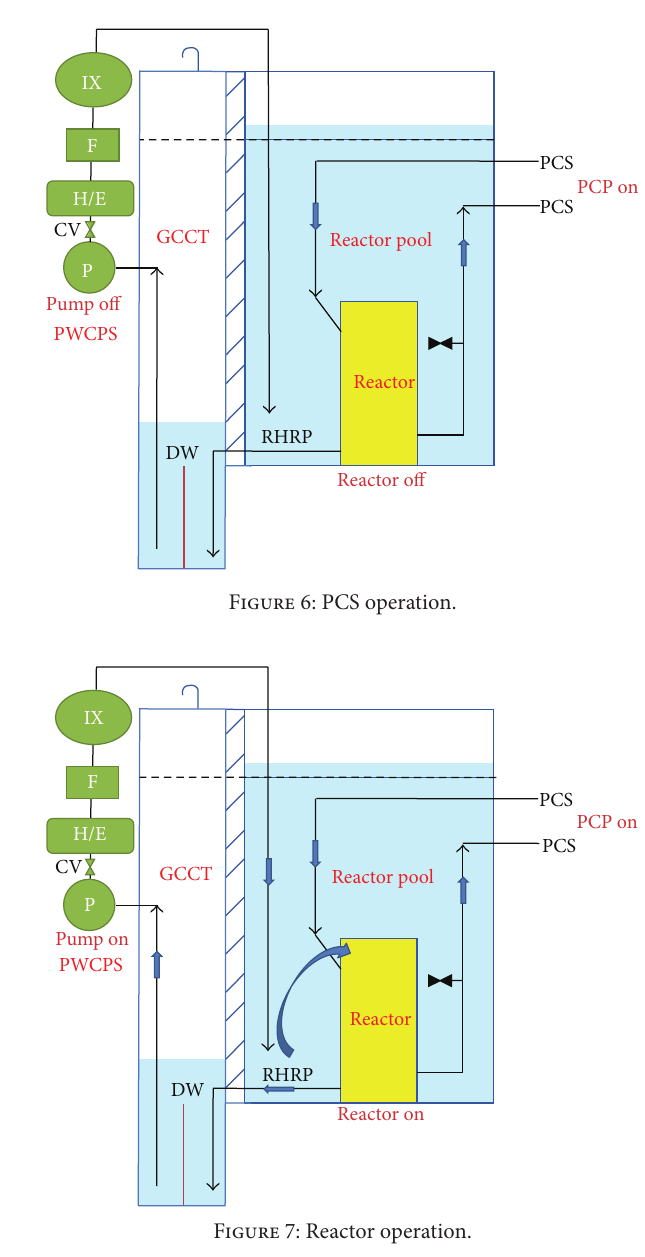
Figure 7: Reactor